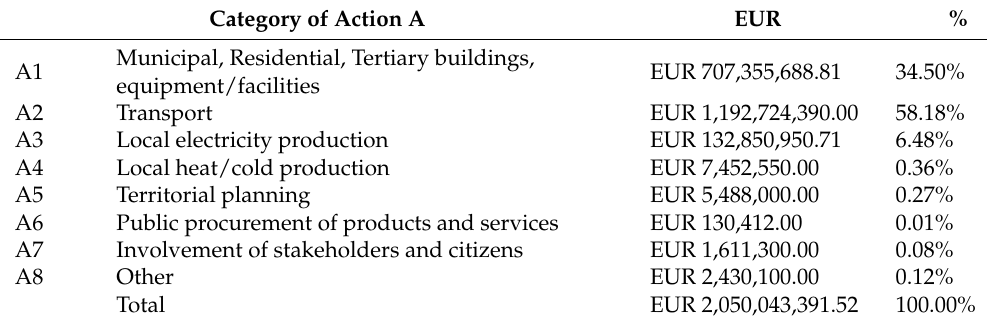
Table 9. Funding is required for SEAP Actions.